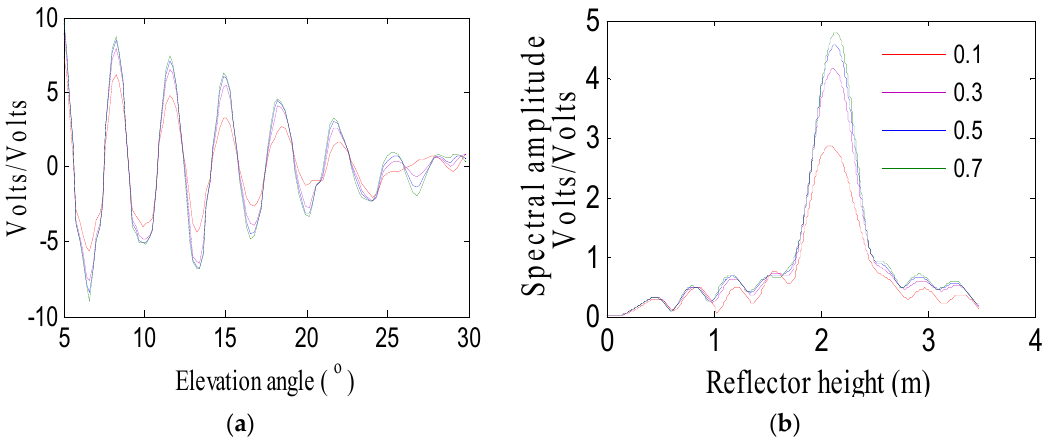
Figure 7. Simulated Signal-to-Noise Ratio (SNR) modulations of different snow densities (g/cm 2 ). ( a ) SNR modulations after removing the direct trend; ( b ) Lomb–Scargle periodogram of multipath pattern.